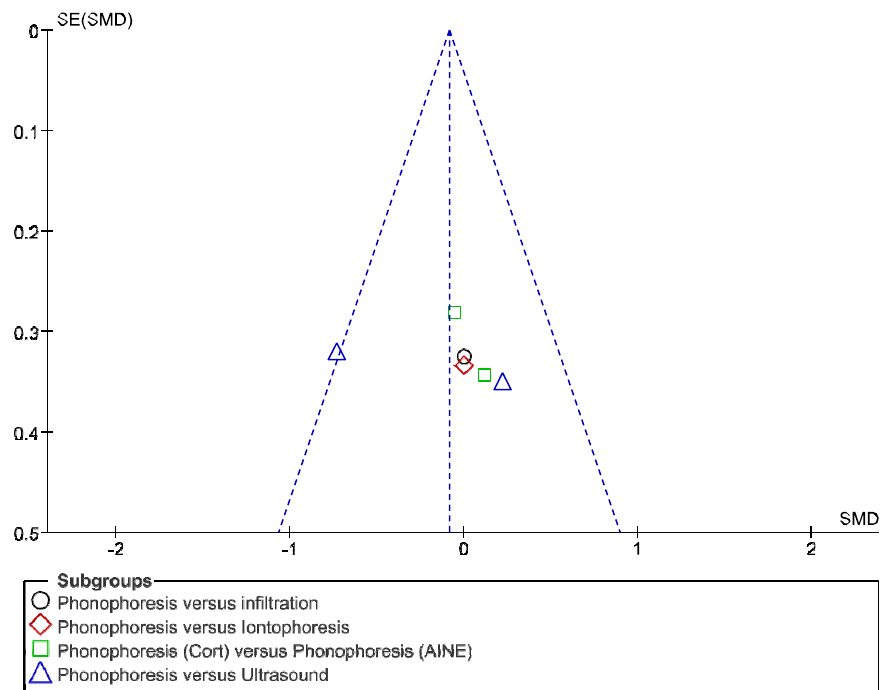
Figure 16. Phonophoresis for BCTQ Function.